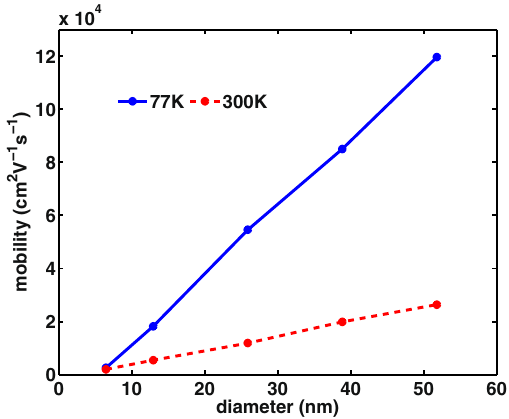
Figure 3. Size dependence of mobility of the InSb nanowires calculated at 77 K (blue dots) and 300 K (red